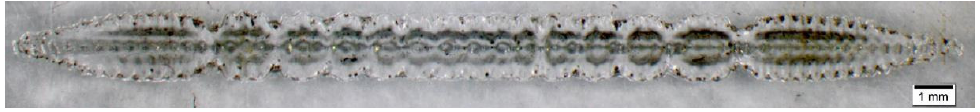
Figure 2. A photograph of a plexiglass plate after the mode shot performed with the applied laser beam.